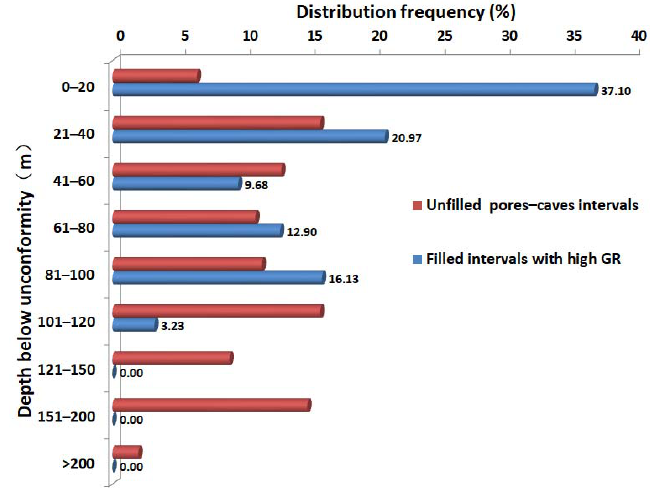
Figure 4. Distribution characteristics of mud ‐ filled caves and unfilled caves.